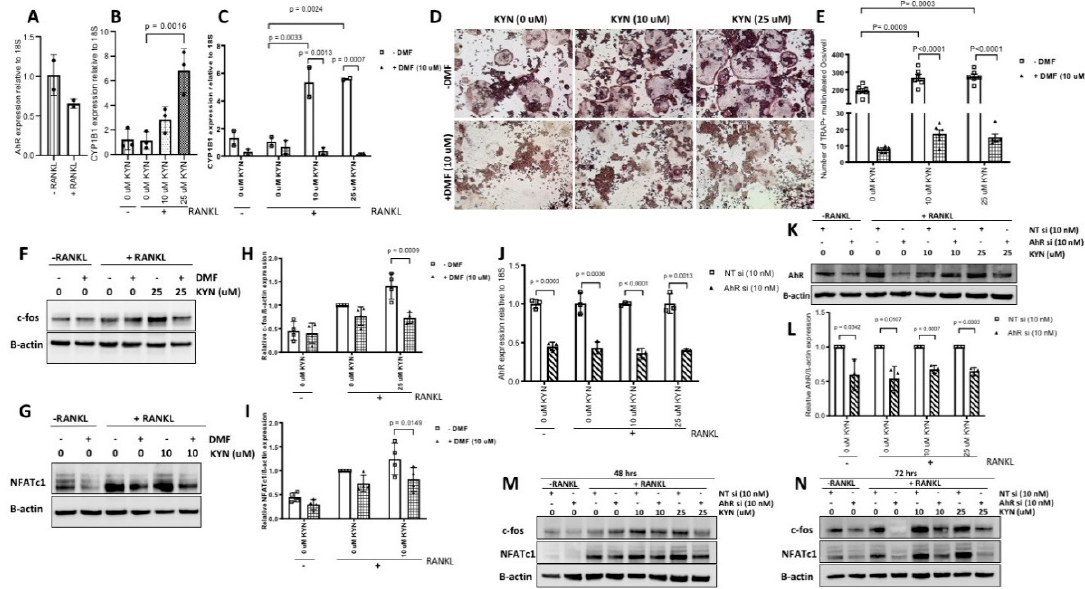
Figure 4. Blocking AhR signaling attenuates KYN/RANKL regulation of osteoclast differentiation in Raw 264.7 cells via inhibition of c-fos and NFATc1. ( A ) mRNA expression level of AhR in Raw 264.7 cells in the absence or presence of RANKL for 24 h. Data are presented relative to—RANKL control. Data are representative of two independent experiments and presented as mean ± SD. Unpaired t-test was applied. ( B ) mRNA expression level of CYP1B1 in Raw 264.7 cells treated with KYN (10 or 25 μ M) in presence of RANKL for 24 h. Data are presented relative to RANKL-only (0 μ M KYN) control. Data are representative of three independent experiments and presented as mean ± SD. A one-way ANOVA test was applied. ( C ) mRNA expression level of CYP1B1 in Raw 264.7 cells treated with RANKL/KYN at concentration of 10 μ M or 25 μ M KYN for 24 h in presence or absence of DMF (10 μ M). Data are presented relative to RANKL-only (0 μ M KYN) control. Data are representative of two independent experiments and presented as mean ± SD. A two-way ANOVA test was applied. ( D ) Representative images of TRAP stained Raw 264.7 cells treated with RANKL/KYN at concentration of 10 or 25 μ M for 5 days with no DMF added (upper panel) or with DMF (10 μ M) (lower panel). ( E ) The total number of TRAP + multinucleated cells per well in each condition. Data are presented as mean ± SD ( n = 5–6). Experiments were repeated three times for each condition. A two-way ANOVA test was applied. Images were taken at 10X objective magnification with scale bar indicated. TRAP + multinucleated cells were counted blindly. ( F , G ) Representative Western blotting of c-fos and NFATc1 proteins expression in Raw 264.7 cells treated with RANKL/KYN (10 or 25 μ M) for 24 h in the presence or absence of DMF (10 μ M). ( H,I ) Densitometric analysis of c-fos and NFATc1 proteins expression in ( F , G ). Data are expressed as c-fos/ β -actin or NFATc1/ β -actin ratio relative to RANKL-only (0 μ M KYN) control. Data are representative of three independent experiments and presented as mean ± SD. A two-way ANOVA test was applied. ( J ) mRNA expression level of AhR in Raw 264.7 cells transfected with NT siRNA or AhR siRNA before treating with RANKL/KYN (10 or 25 μ M) and collected 48 h post-transfection. Data are presented relative to NT siRNA control for each condition. Unpaired t-test was applied. ( K ) Representative Western blotting of AhR protein expression in Raw 264.7 cells transfected with NT siRNA or AhR siRNA before treating with RANKL/KYN (10 or 25 μ M) and collected 72 h post-transfection. ( L ) Densitometric analysis of AhR protein expression in ( K ). Data are expressed as AhR/ β -actin relative to NT siRNA control for each condition. Unpaired t-test was applied. Data are representative of two independent experiments and presented as mean ± SD. ( M , N ) Representative Western blotting of c-fos and NFATc1 proteins expression in Raw 264.7 cells transfected with NT siRNA or AhR siRNA before treating with RANKL/KYN (10 or 25 μ M) and collected 48 h ( M ) or 72 h ( N ) post-transfection. Data are representative of two independent experiments.